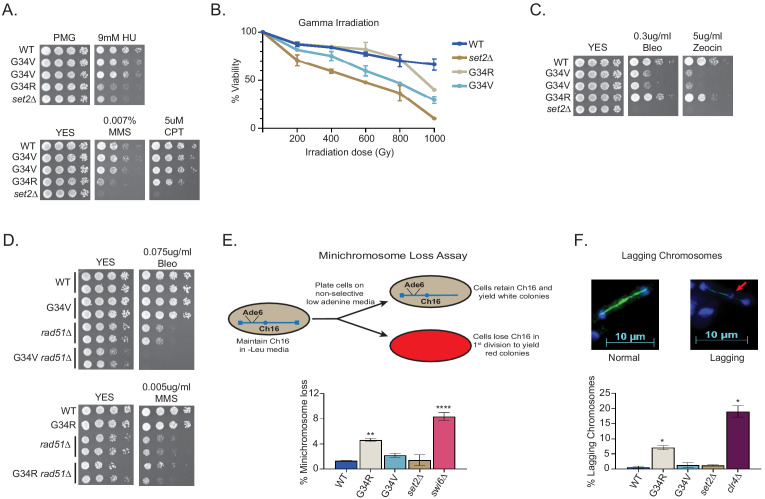
DNA damage sensitivity and chromosomal stability differ between H3-G34R and H3-G34V mutants.(A) Fivefold serial dilutions showing the effect of hydroxyurea (HU; a ribonucleotide reductase inhibitor that depletes dNTPs), methyl methanesulfonate (MMS; a DNA-alkylating agent), and camptothecin (CPT; blocks topoisomerase one ligase activity) on growth of the indicated strains. (B) Effect of γ−irradiation (IR) exposure on viability of H3-WT, H3-G34R, H3-G34V, set2Δ, and H3-G34V set2Δ cells. Data represent mean ± SEM from two independent experiments using four biological replicates. (C) Serial dilution assay showing the effect of bleomycin and zeocin, two IR mimetics, on the indicated strains. (D) Serial dilution assay assessing epistasis of mutants with HR pathway. Bleomycin sensitivity of H3-WT, H3-G34V, rad51Δ, and H3-G34V rad51Δ cells (top) and MMS sensitivity of H3-WT, H3-G34R, rad51Δ, and H3-G34R rad51Δ cells (bottom). (E) Frequency of cells that lose the non-essential minichromosome Ch16 in H3-WT, H3-G34V, H3-G34R, set2Δ, and swi6Δ cells. Mean ± SEM from four to eight biological replicates is shown. ** denotes a significant difference of p<0.01 and ****p<0.0001 compared with the H3-WT strain. (F) Example of a normal anaphase and one with a lagging chromosome (red arrow) (top). Frequency of late anaphase cells with a lagging chromosome in H3-WT, G34R, G34V, set2Δ, and clr4Δ (bottom). Mean ± SEM from four to eight biological replicates. * represents significant difference of p<0.05 with the H3-WT strain.